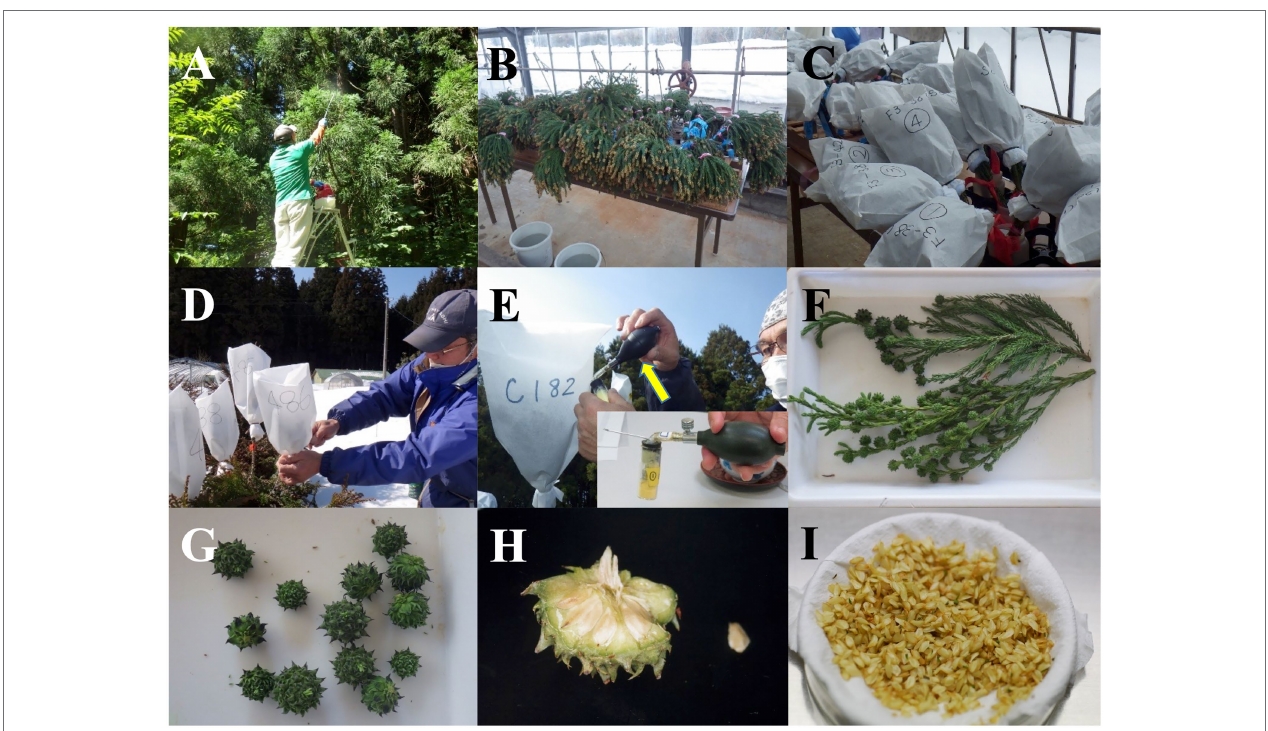
FIGURE 1 | Plant material preparation for the propagation of pollen-free sugi ( C. japonica ) via somatic embryogenesis. (A) Application of gibberellin (GA 3 ) to promote flowering. (B) Harvested branches with male flowers. (C) Branches with male flowers in bottles with water and covered with paper bags for pollen collection. (D) Covering of female flowers with pollination bags. (E) Injection of pollen into pollination bags with a pollen atomizer (yellow arrow; atomizer amplification is seen in the bottom right square). (F) Harvested branches with seed cones. (G) Collected seed cones. (H) Opened cone for seed extraction (cone size: 15 mm in diameter). (I) Seeds removed from cones (Petri dish size: 90 mm in